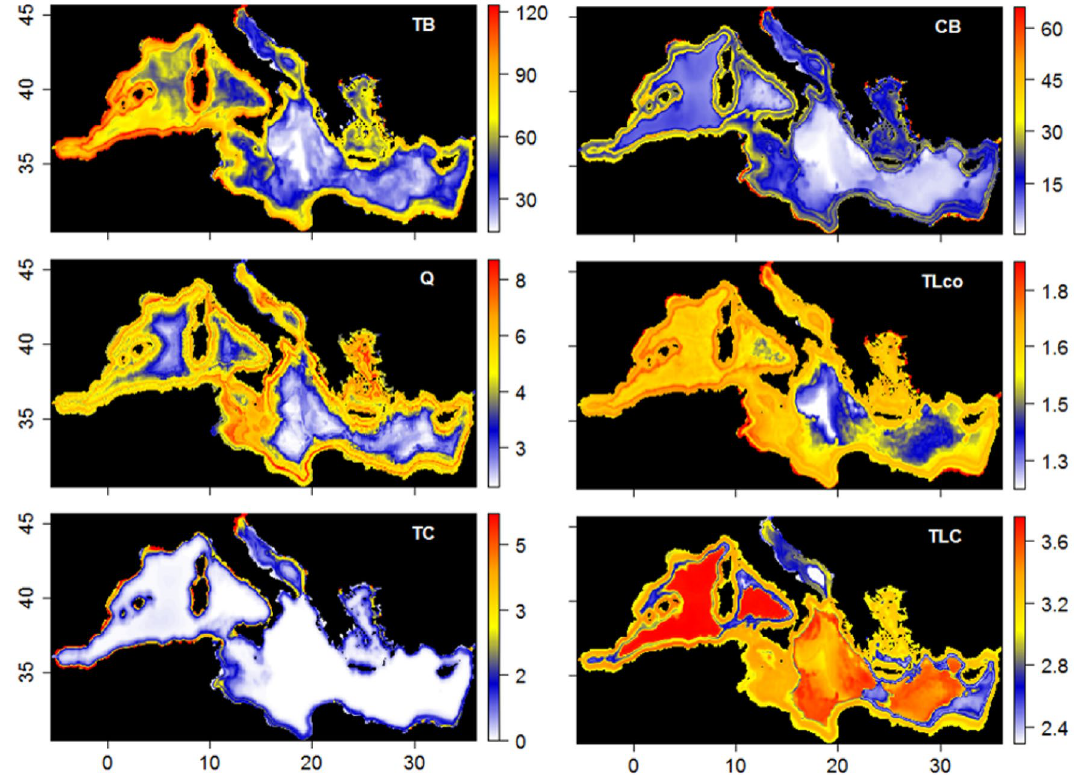
Figure 1. Mean (1995–2016) of selected modelled indicators. TB Total biomass (t/km 2 ), CB commercial biomass (t/km 2 ), Q Kempton index, TL co Trophic level (TL) of species/Fg in the community, TC Total catch (t/ km 2 /year), TLC Trophic level (TL) of the